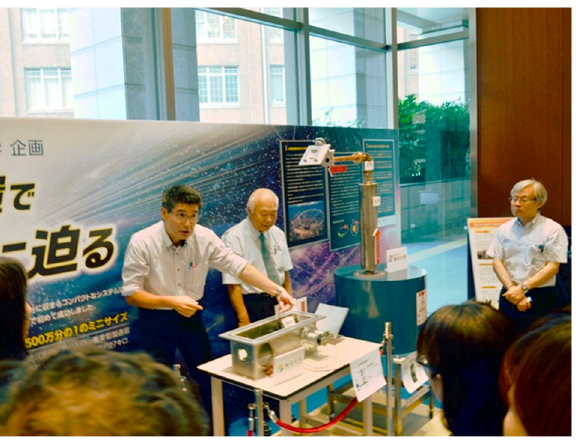
Figure 7. Demonstration of a table-top experiment by Prof. S. Asai (University of Tokyo) and Prof. T. Idehara (University of Fukui) in October 2016.